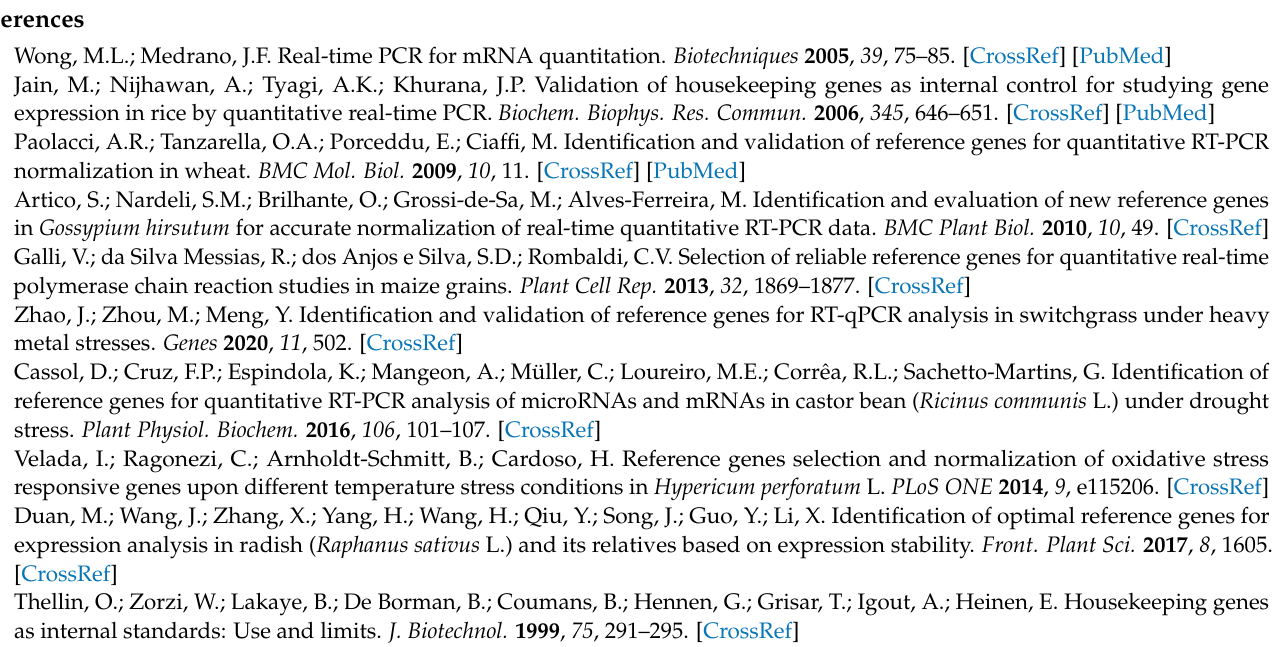
reference genes and target genes; Figure S2: Standard curves of the candidate reference genes and target genes; Figure S3: Average expression stability M value of nine candidate reference genes calculated with GeNorm by organ; Figure S4: The pairwise variation (V) measure of the nine candidate reference genes using GeNorm by group. Table S1: Information of candidate reference genes, target genes, and primers for RT-qPCR; Table S2: Ct values for nine candidate reference genes in organs under different abiotic stresses or hormone treatments; Table S3: Expression stability ranking of the nine candidate reference genes estimated by geNorm, NormFinder, BestKeeper and